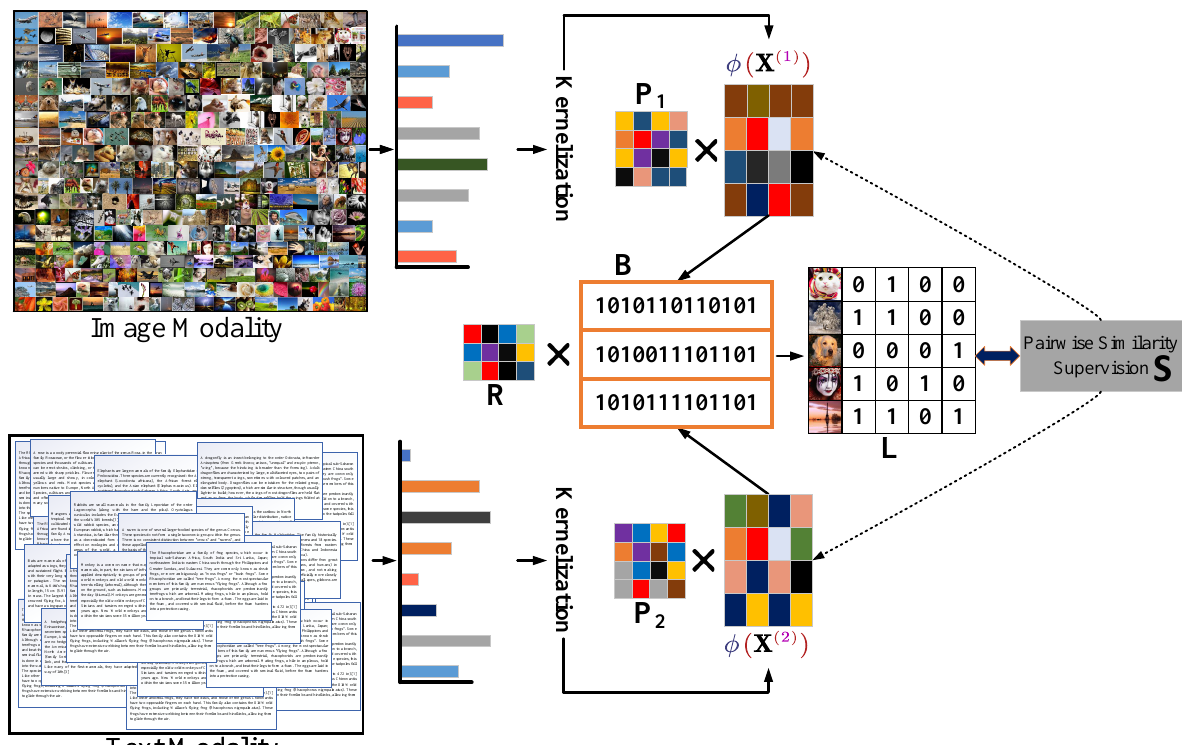
Figure 1. The framework of D iscrete S emantics-Guided A symmetric H ashing (DSAH). In our proposed DSAH, we first handle the nonlinear relations in different modalities with the kernelization, then an asymmetric learning scheme is proposed to effectively perform the hash learning process; meanwhile, our proposed method fully considers the label information to enhance the semantic information. In addition, a discrete optimization algorithm is proposed to solve the discrete